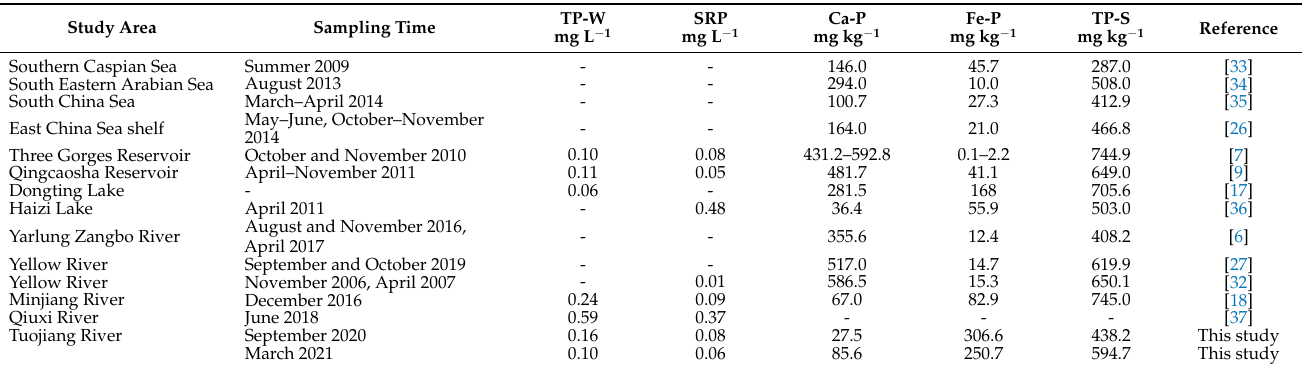
Table 1. Comparisons of phosphorus concentrations in water–sediment phases in different aquatic